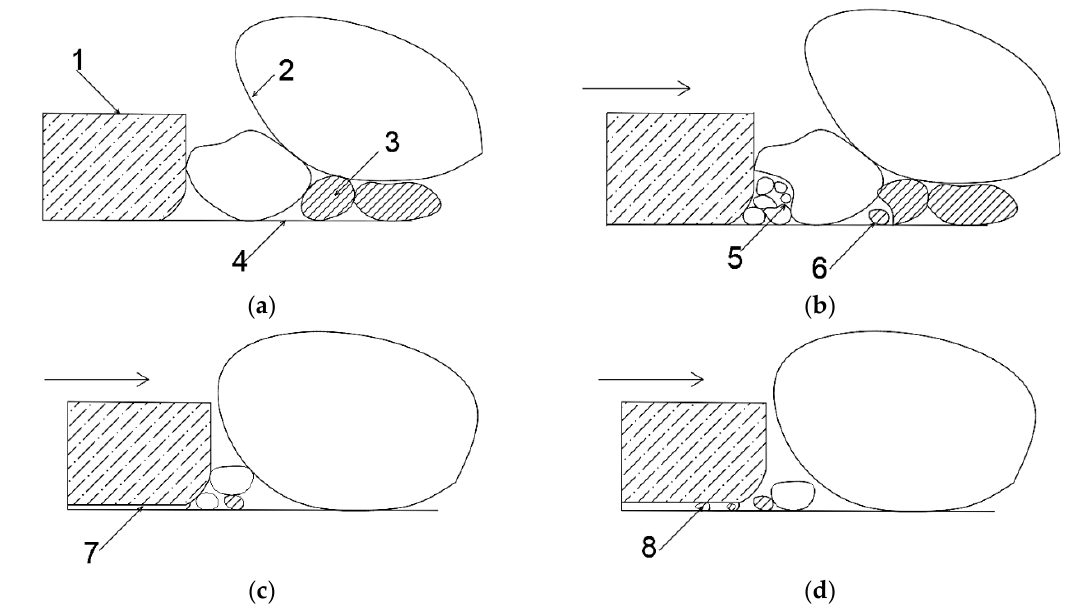
Figure 2. Model of the processes of coal grinding and sliding metal sheets wear, ( a )—moving the blocks by a scraper, ( b )—stage of initial crushing, ( c )—stage of secondary crushing and creation of a ground coal layer, ( d )—stage of wearing the trough surface by mineral grains and wear products in a presence of ground coal. 1—scraper, 2—coal grains, 3—rock grains, 4—sliding metal sheets of a trough, 5—ground coal grains, 6—ground rock grains, 7—layer of ground coal, 8—rock grains surrounded by ground